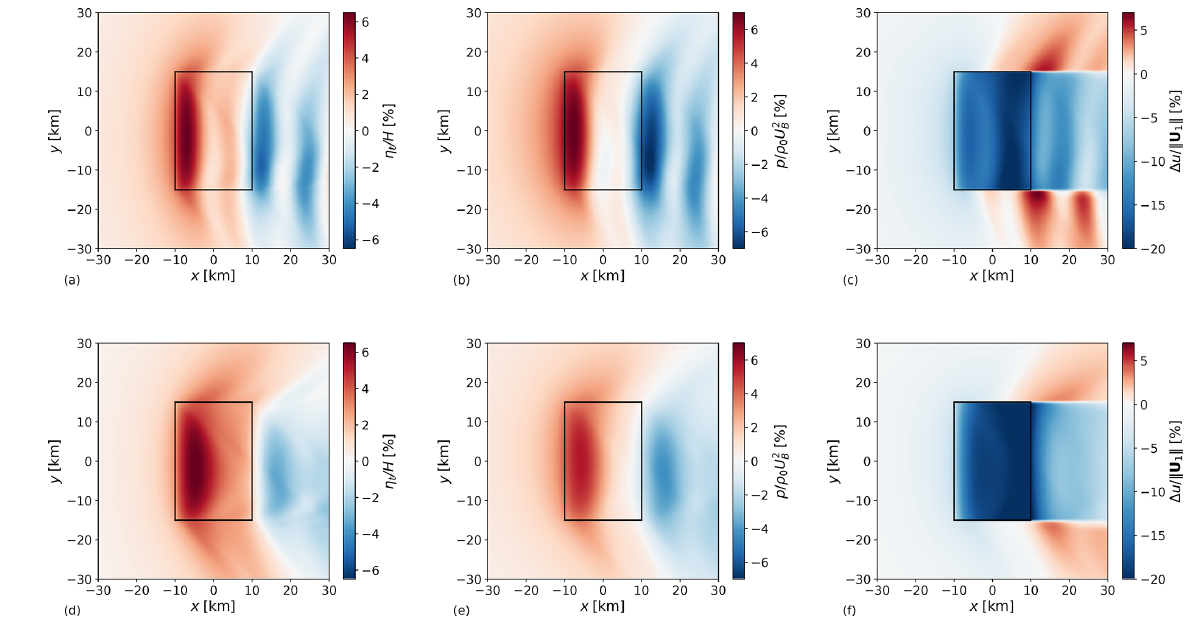
Figure 2. Planform view of inversion-layer displacement (a, d) , pressure perturbation (b, e) and relative velocity reduction (c, f) in the wind- farm layer in subcritical ( a–c , Fr = 0 . 9) and supercritical ( d–f , Fr = 1 . 1) flow conditions. The black rectangle indicates the wind-farm region.